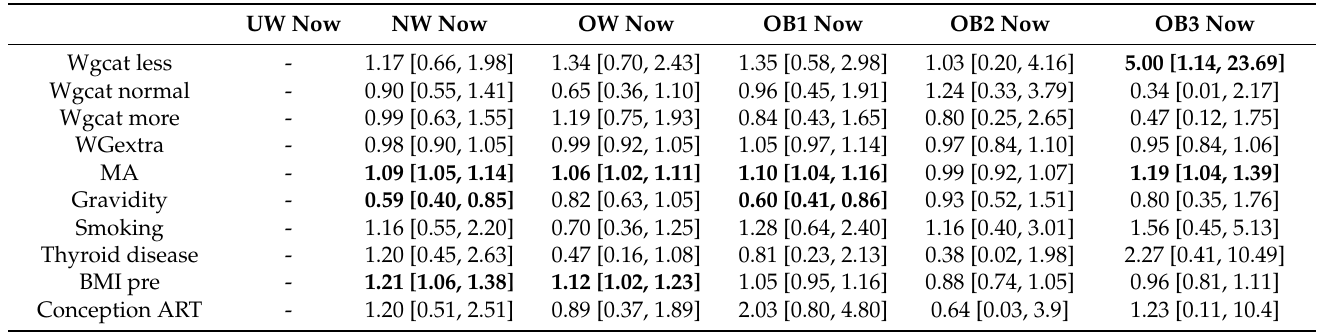
Table 7. Subgroup analyses for each BMI category at 20 +0 –23 +6 weeks of gestation, adjusted for MA, gravidity, smoking, thyroid disease, BMI pre, and conception method ART.